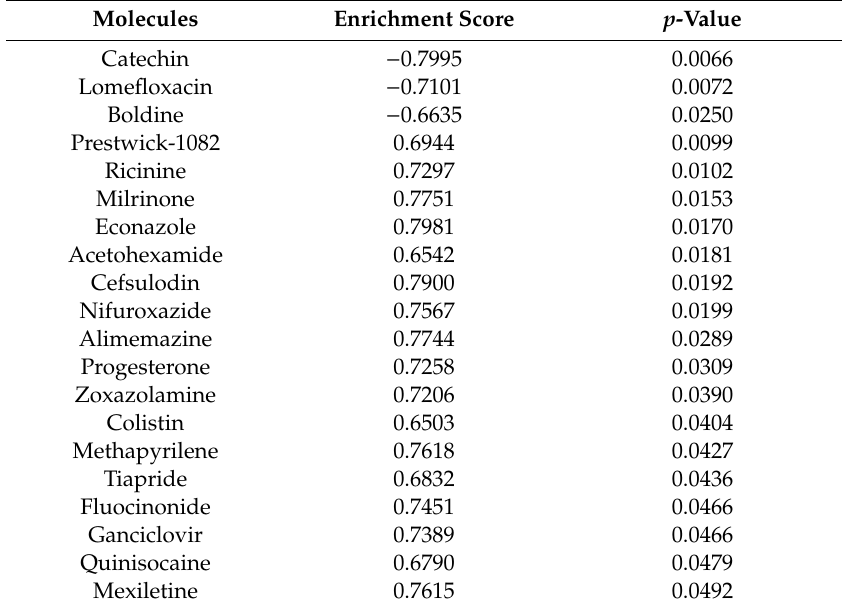
Table 5. List of small molecules enriched from CMap